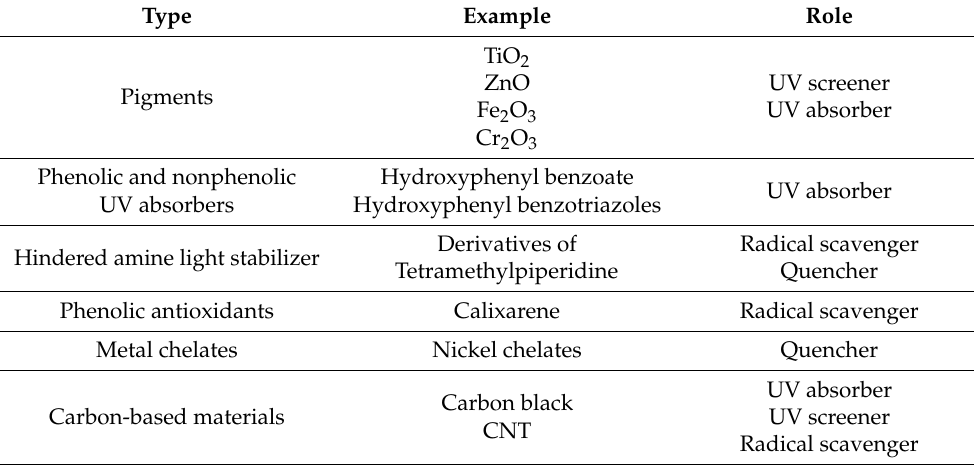
UV screener UV absorber